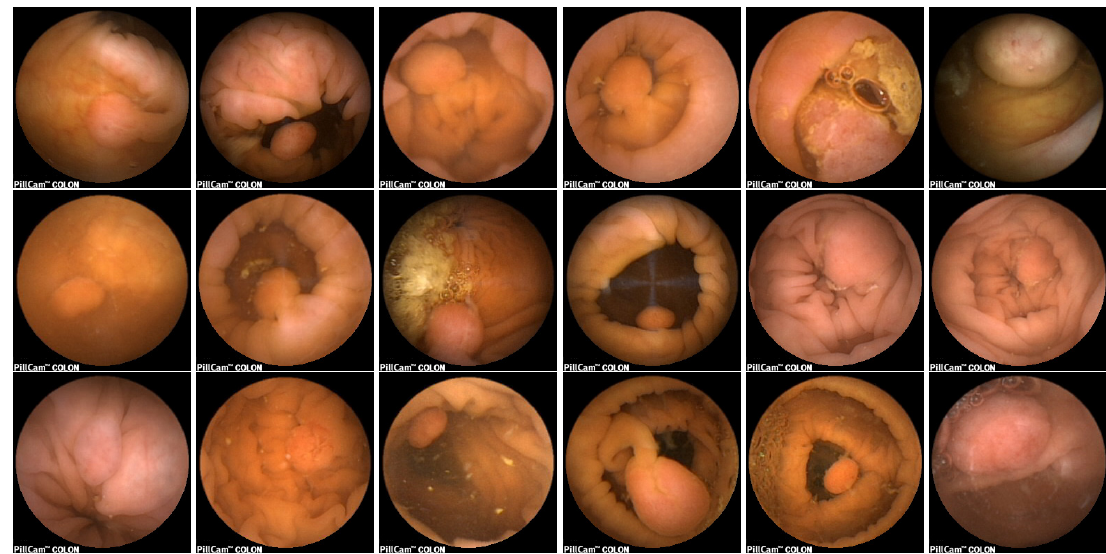
Figure 1. Variability of appearance in colonic polyps under the video capsule endoscopy (VCE) imaging system. Images are taken from PillCam R (cid:13) COLON capsule(Given Imaging Inc., Yoqneam, Israel) based exams on different patients. Notice the blurring, color, texture and geometric features (or lack of) at various levels. Other interferences for feature detectors are turbid gastrointestinal (GI) liquids. Trash which is present due to VCE exams does not involve colon cleaning unlike traditional colonoscopy imaging